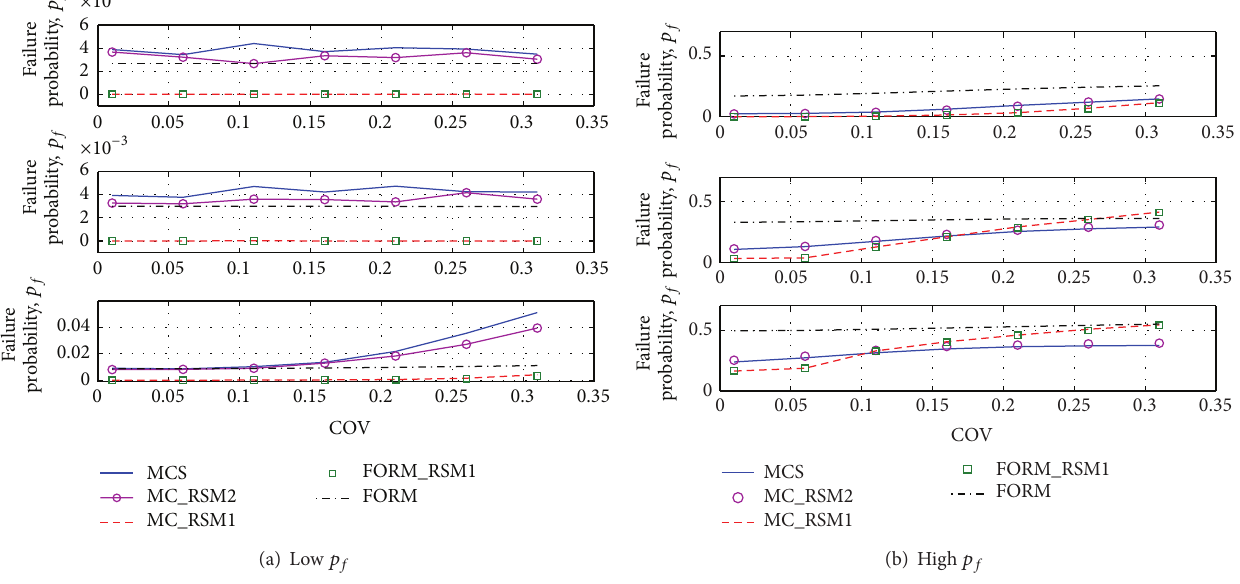
Figure 12: Comparison among MCS, MC RSM1, MC RSM2, FORM RSM1, and FORM at (a) low and (b) high failure